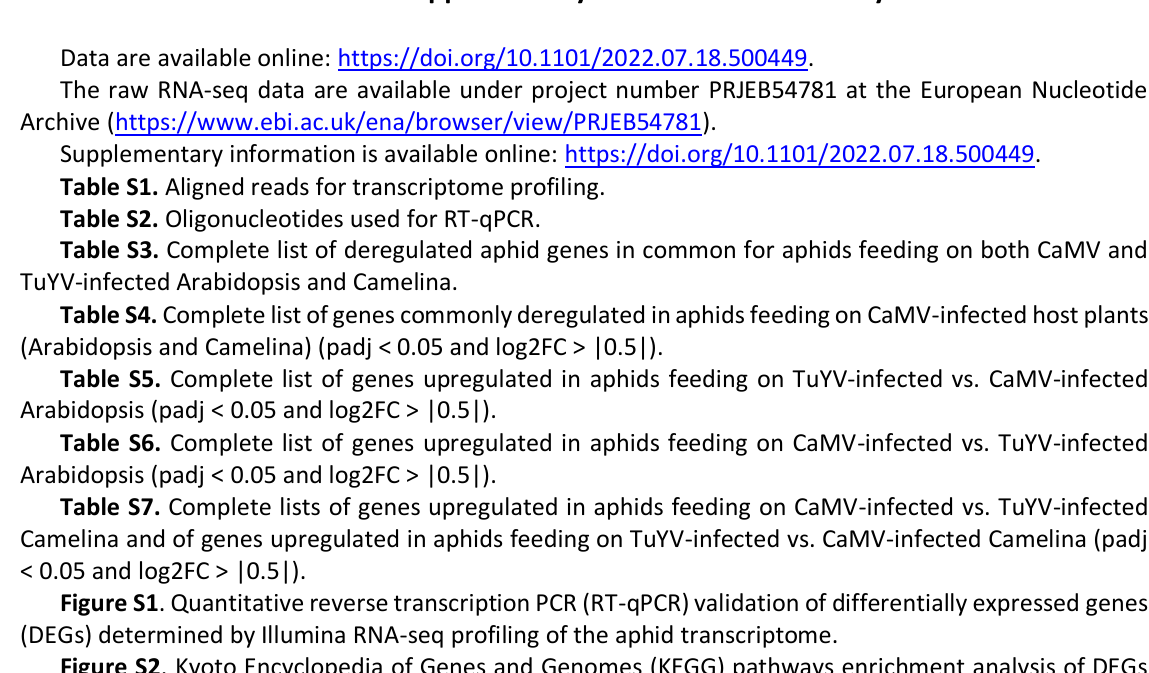
Table S2. Oligonucleotides used for RT-qPCR. Table S3. Complete list of deregulated aphid genes in common for aphids feeding on both CaMV and TuYV-infected Arabidopsis and Camelina. Table S4. Complete list of genes commonly deregulated in aphids feeding on CaMV-infected host plants (Arabidopsis and Camelina) (padj < 0.05 and log2FC > |0.5|). Table S5. Complete list of genes upregulated in aphids feeding on TuYV-infected vs. CaMV-infected Arabidopsis (padj < 0.05 and log2FC > |0.5|). Table S6. Complete list of genes upregulated in aphids feeding on CaMV-infected vs. TuYV-infected Arabidopsis (padj < 0.05 and log2FC > |0.5|). Table S7. Complete lists of genes upregulated in aphids feeding on CaMV-infected vs. TuYV-infected Camelina and of genes upregulated in aphids feeding on TuYV-infected vs. CaMV-infected Camelina (padj < 0.05 and log2FC > |0.5|). Figure S1 . Quantitative reverse transcription PCR (RT-qPCR) validation of differentially expressed genes (DEGs) determined by Illumina RNA-seq profiling of the aphid transcriptome. Figure S2 . Kyoto Encyclopedia of Genes and Genomes (KEGG) pathways enrichment analysis of DEGs (log2FC > 1) in Myzus persicae in response to TuYV or CaMV infection in Arabidopsis or Camelina plants. Dataset S1. RNA-seq data used to establish the